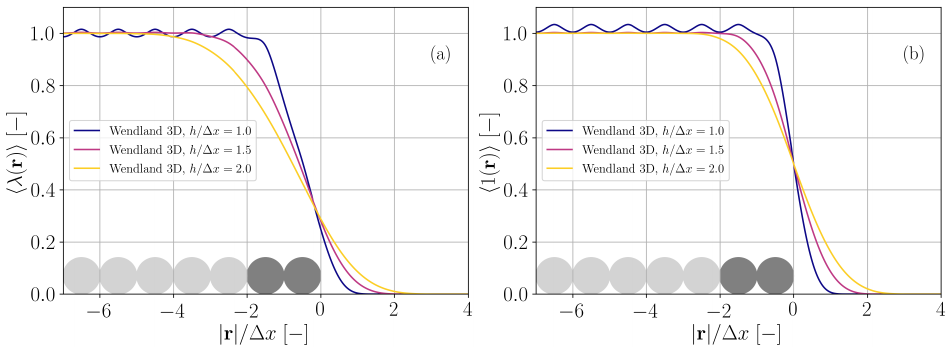
Figure A1. Functions that are approximately 1 inside and 0 outside the particle distribution for different ratios of smoothing length and particle spacing. The 3D Wendland kernel is used as an example. The particle positions are indicated by the circles. ( a ) Minimum eigenvalue of the inverse renormalization tensor (Equation (A1)). ( b ) Unity field (Equation (A2)).